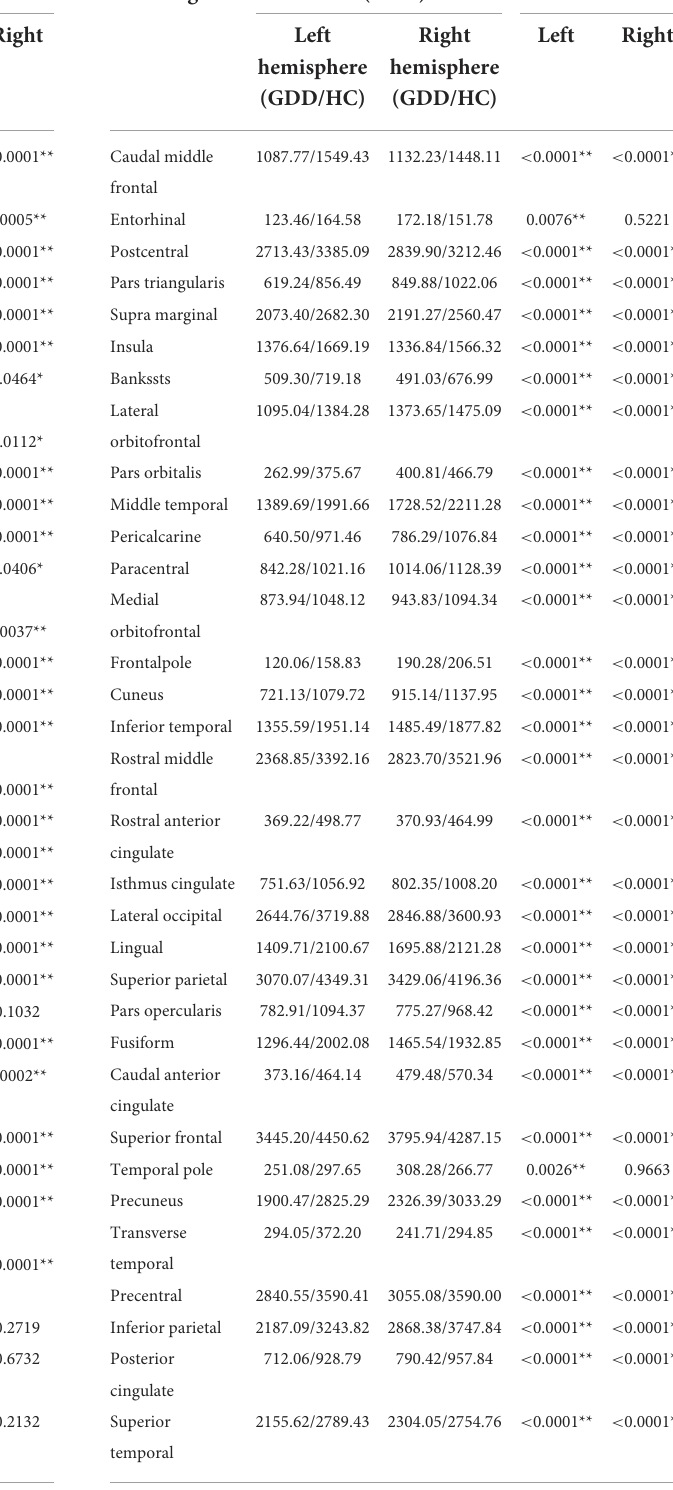
TABLE 2 Brain cortical regions that show significant differences in cortical surface area (SA) between the two groups. Brain region SA (mm 2 ) P Left Right Left Right hemisphere